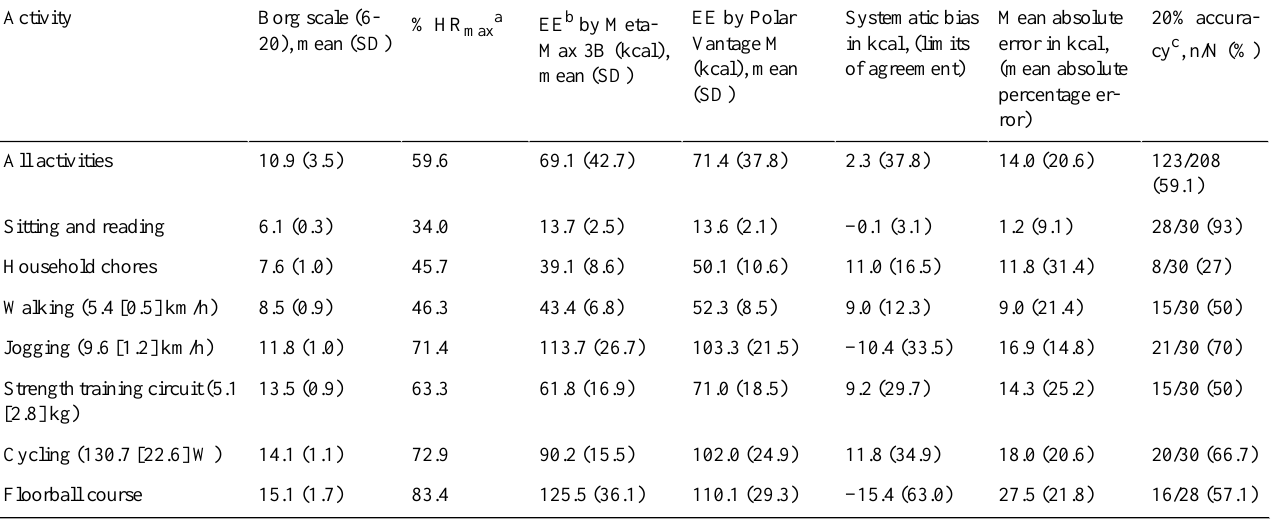
Table 2. Perceived exertion, heart rate, measured energy expenditure, and error rates of the Polar Vantage M when compared with the MetaMax